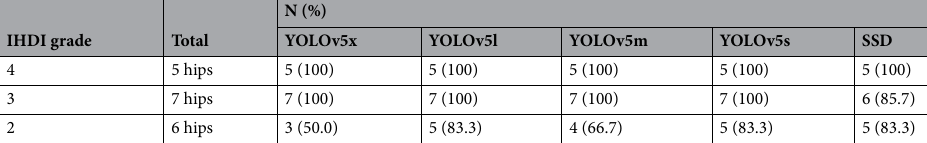
Table 3. DDH hips correctly labeled “DDH”, according to IHDI grade. DDH Developmental dysplasia of the hip, IDHI International Hip Dysplasia Institute, SSD Single shot multi-box detector, YOLO “You Only Look Once”.